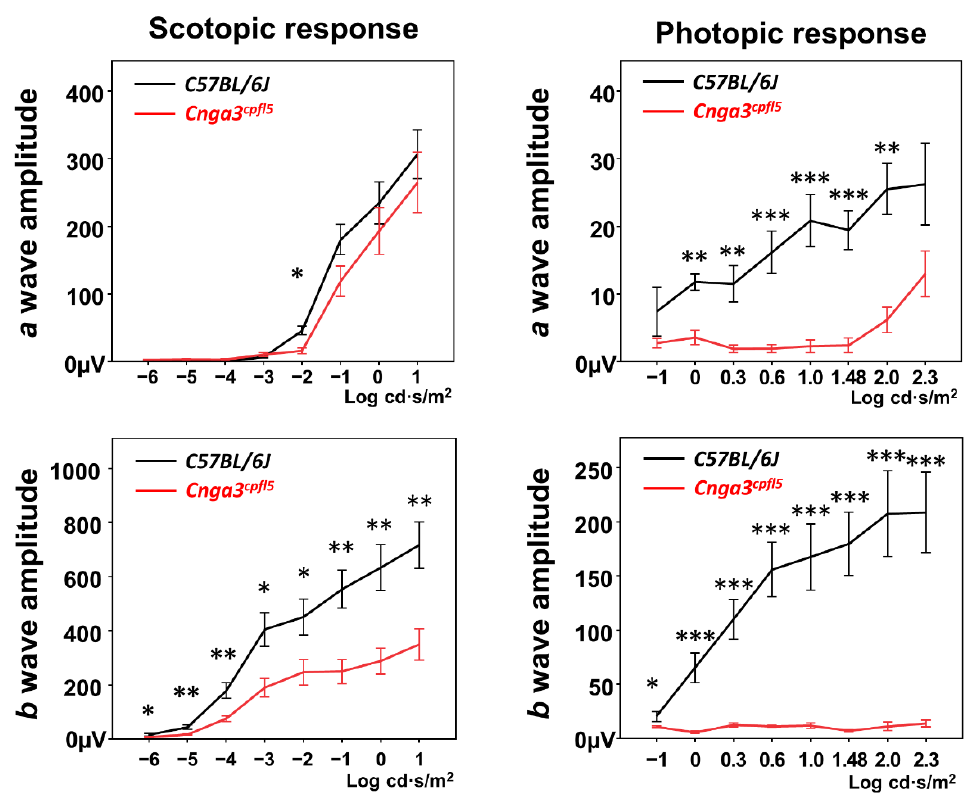
Figure 1. Electroretinography (ERG) of Cnga3 cpfl5 mice at one month old. ( Left ) Scotopic serial intensity ERG tracings showed statistically significant decreased b -wave amplitudes in Cnga3 cpfl5 mice compared to age-matched C57BL/6J mice. ( Right ) Photopic serial intensity ERG in Cnga3 cpfl5 mice showed nearly extinguished b -wave amplitudes and statistically significantly decreased b -wave amplitudes compared to the b -wave amplitudes in age-matched C57BL/6J mice. (n Cnga3cpfl5 = 5, n C57BL/6J = 3). * p < 0.05, ** p < 0.01, *** p <